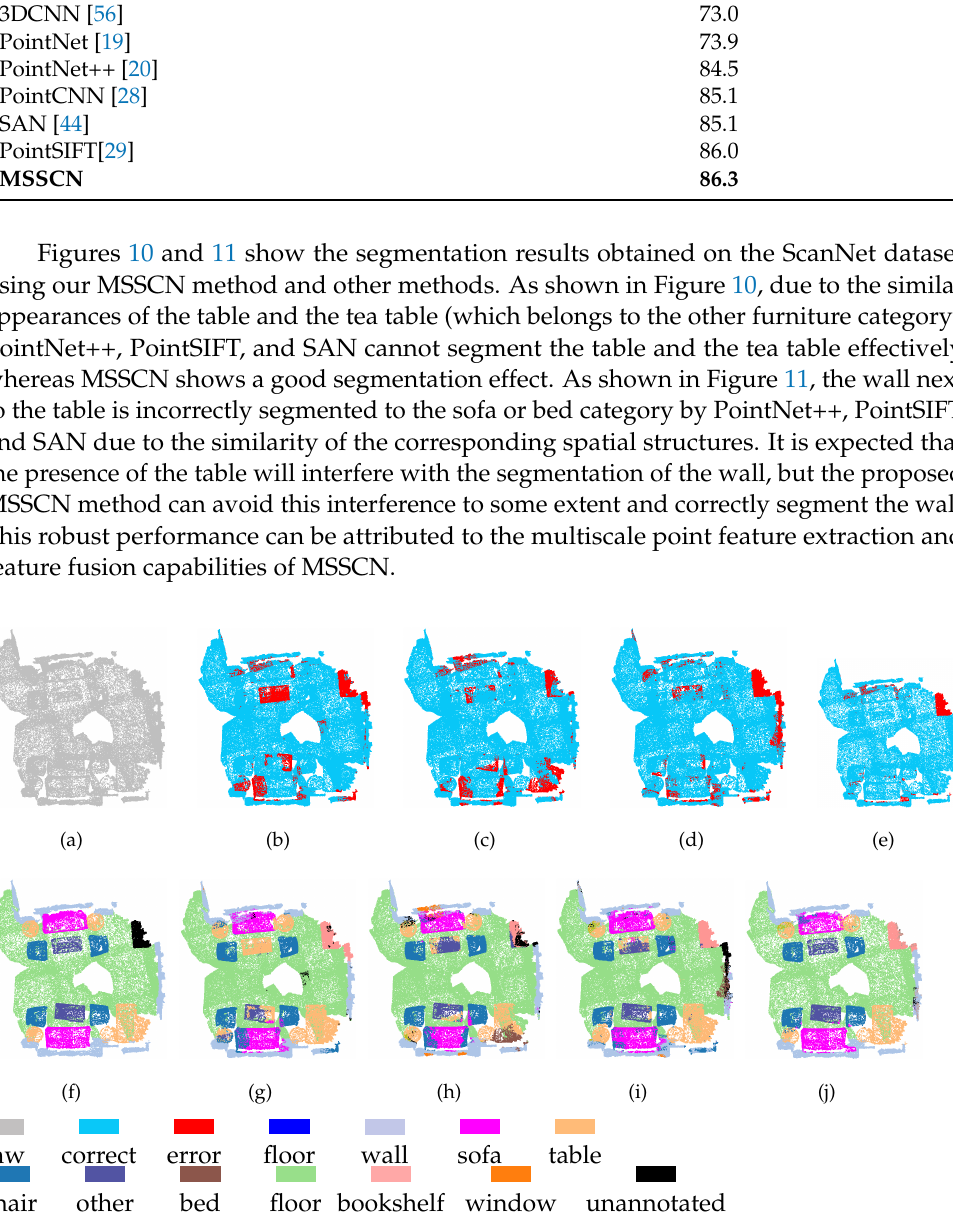
Figure 10. Segmentation results on ScanNet-1 dataset: ( a ) input, ( f ) ground truth, ( b , g ) PointNet++, ( c , h ) PointSIFT, ( d , i ) SAN , and ( e , j )